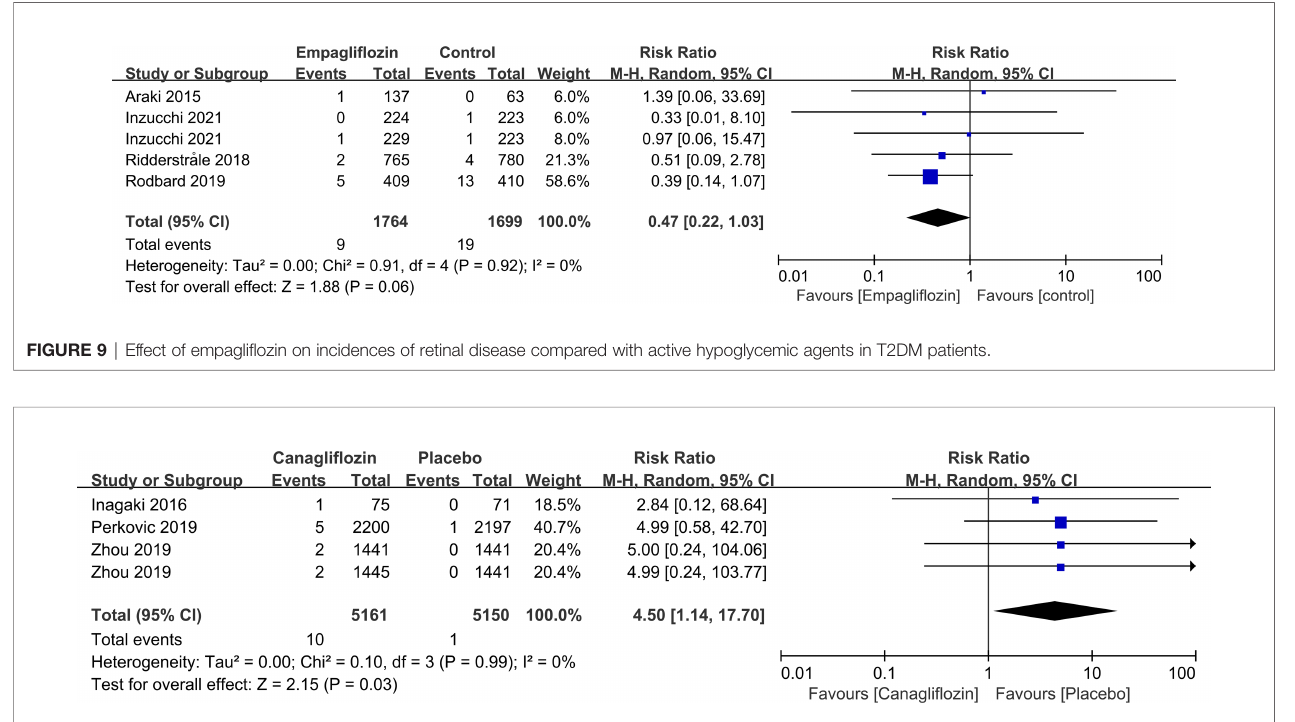
FIGURE 10 | Effect of canagli fl ozin on incidences of vitreous disease compared with placebo in T2DM